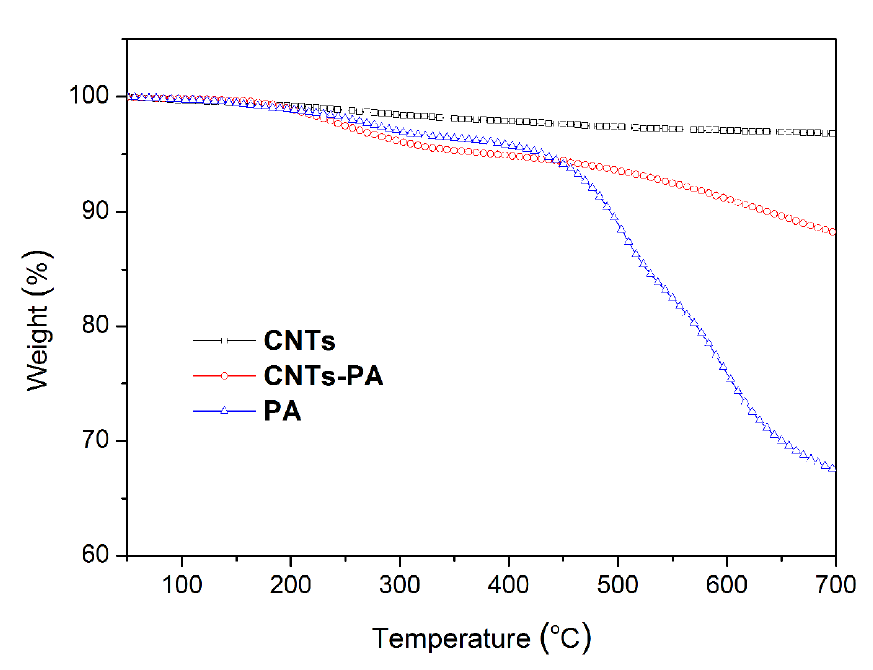
Figure 5. TGA curves of CNTs, PA and CNTs-PA.